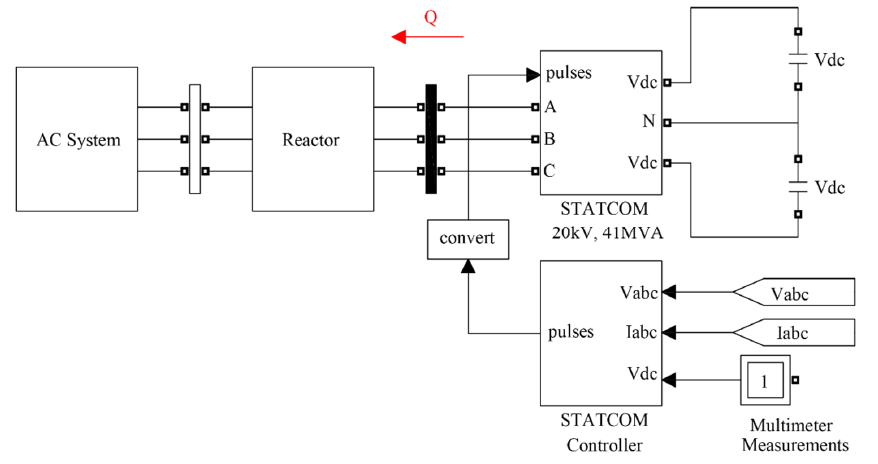
Figure 3. STATCOM concept.